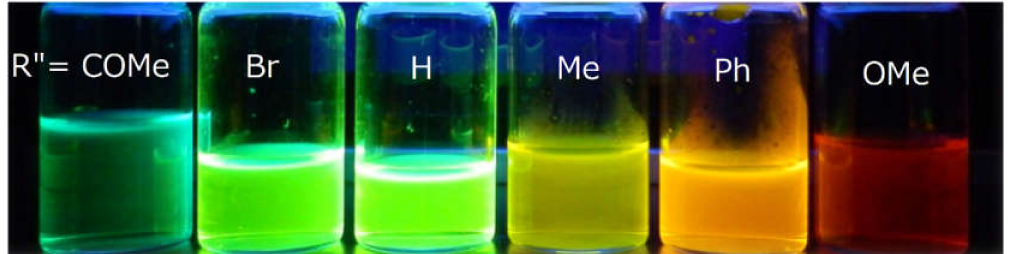
Figure 3. Photos of 2-phenylazulenes 171 in acidic media (30% CF 3 CO 2 H/CH 2 Cl 2 ) under the irradiation of UV-light ( λ ex = 365